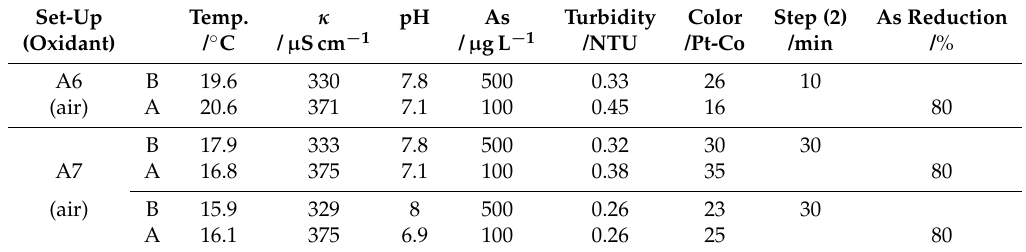
Table 2. Experimental results obtained in Experiments A6–A13. B and A stand for the conditions before and after the reaction, respectively. The values in the ’As’-column are measured with the test strips and the values in the brackets with ICP-MS. The reduction was always calculated conservatively, i.e., using the highest